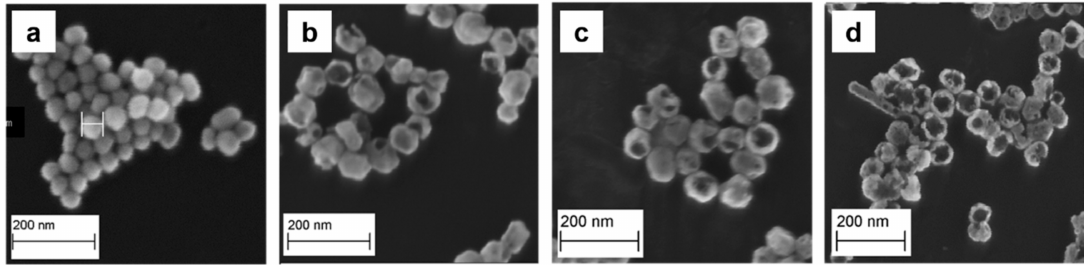
Figure 1. Scanning electron microscopy (SEM) images of ( a ) silver nanoparticles and gold-silver nanoshells synthesized by adding ( b ) 12.5 mL, ( c ) 30 mL, and ( d ) 150 mL of K-Au